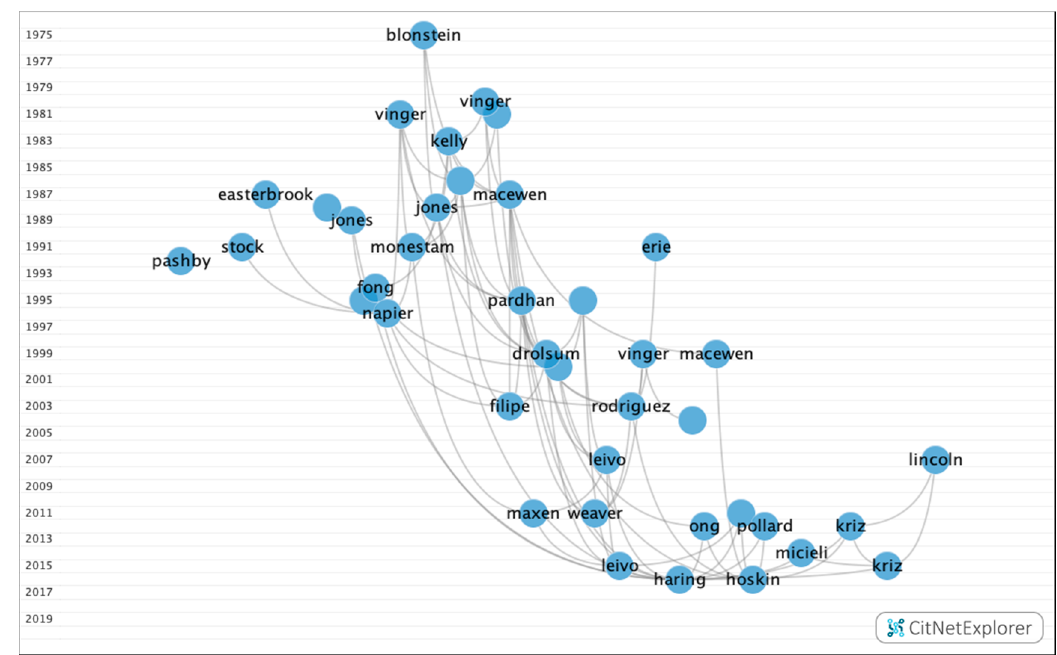
Figure 4. Citation network in group 1.